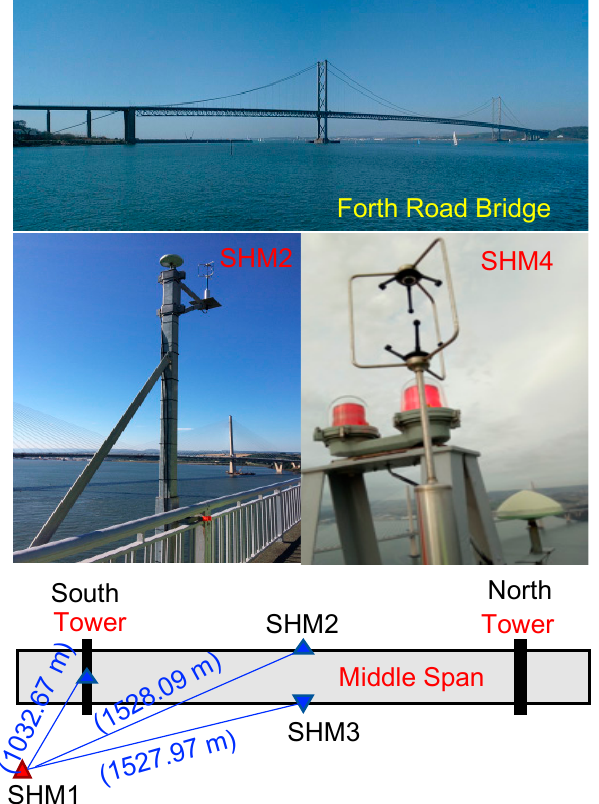
Figure 8. The landscape of the FRB, antenna set-ups with baseline lengths and the observation environment of the SHM2 and SHM4 stations.